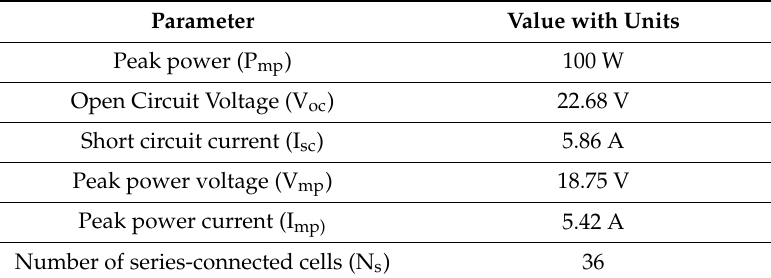
Table 1. Specification of the solar